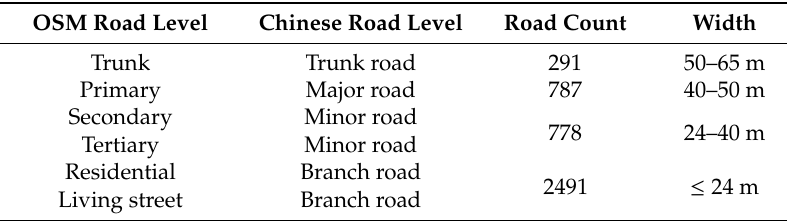
Figure 2. Four types of topological errors exist in OpenStreetMap (OSM) road networks. The red symbol in the first row shows the location of existing errors, and the second row shows the results of the topological correction. Table 2. The corresponding relationship between the OpenStreetMap (OSM) road level and the Chinese road level. The road count and the range of road widths of each road level are also listed.